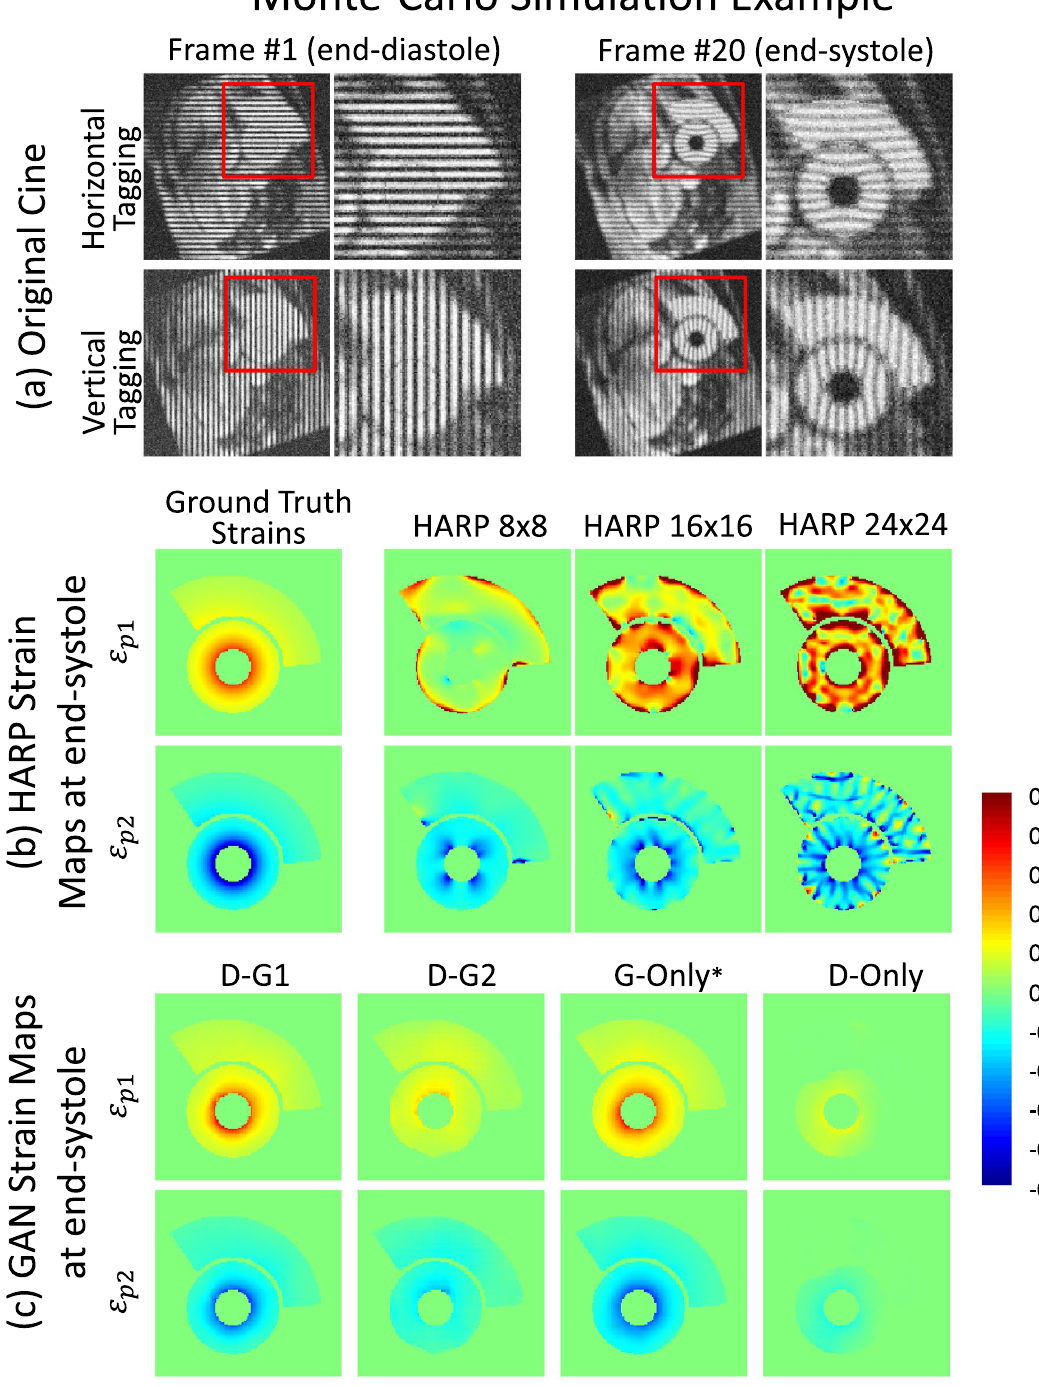
Figure 1. An example of the Monte-Carlo simulated datasets and the corresponding principal strain maps. The principal Eulerian strain maps were estimated using three HARP and four GAN-based methods for the end- systole frame of a simulated dataset. The line tagging images of the end-diastole and end-systole time frames are shown in ( a ). In ( b ), the columns from left to right show the ground truth and the strain maps from the various HARP techniques. Finally, in ( c ), the resulting strain maps from our proposed cGAN techniques are